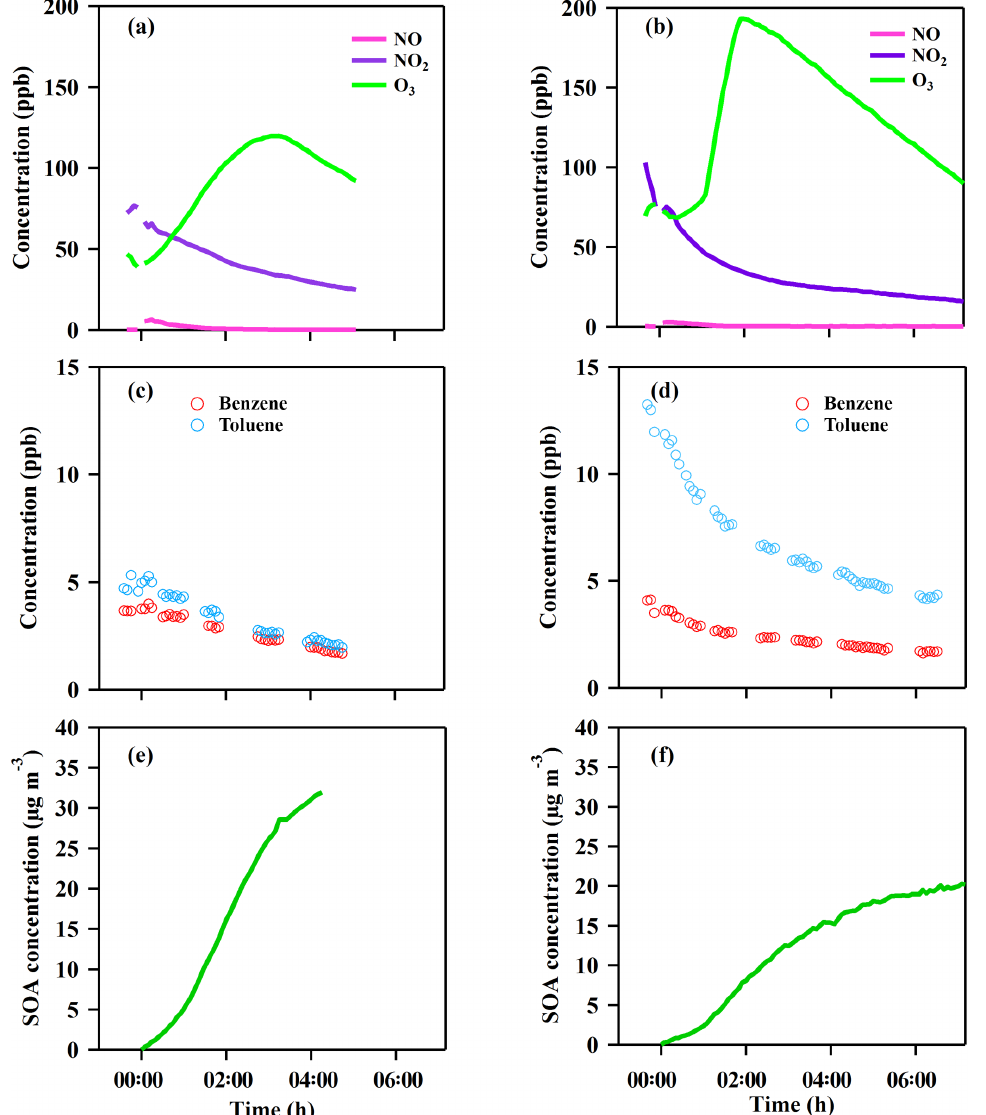
Figure 3. Time series of the gases and particle evolution over the photochemical age in the chamber experiments from the GDI vehicle exhaust (a, c, e) and PFI vehicle exhaust (b, d, f) . Panels (a, b) show NO, NO 2 and O 3 concentration; panels (c, d) show benzene and toluene concentration; panels (e, f) show corrected SOA